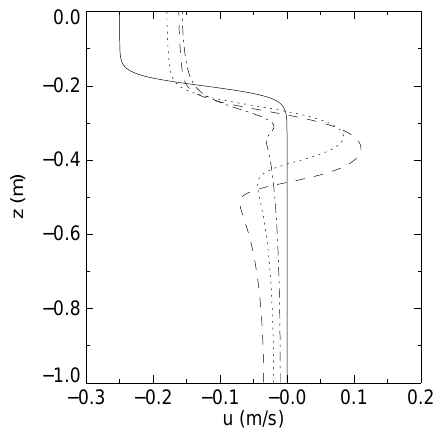
Fig. 2. Horizontal velocity profiles for waves using 1ρ = 0 . 04, U m = − 0 . 25ms − 1 , (d s ,z s ) = ( 0 . 03 , − 0 . 2 ) m and z pyc = − 0 . 2m. Shown is the background velocity profile (solid). The other curves are horizontal velocity profiles down the centre of an ISW. Two cases using d pyc = 0 . 05m are shown for ¯ E a = 1 (dots) and 2 (dashed) Jm − 1 . The dash-dot curve shows the velocity profile for a wave with a thinner pycnocline, d pyc = 0 . 025m, with ¯ E a = 1Jm − 1